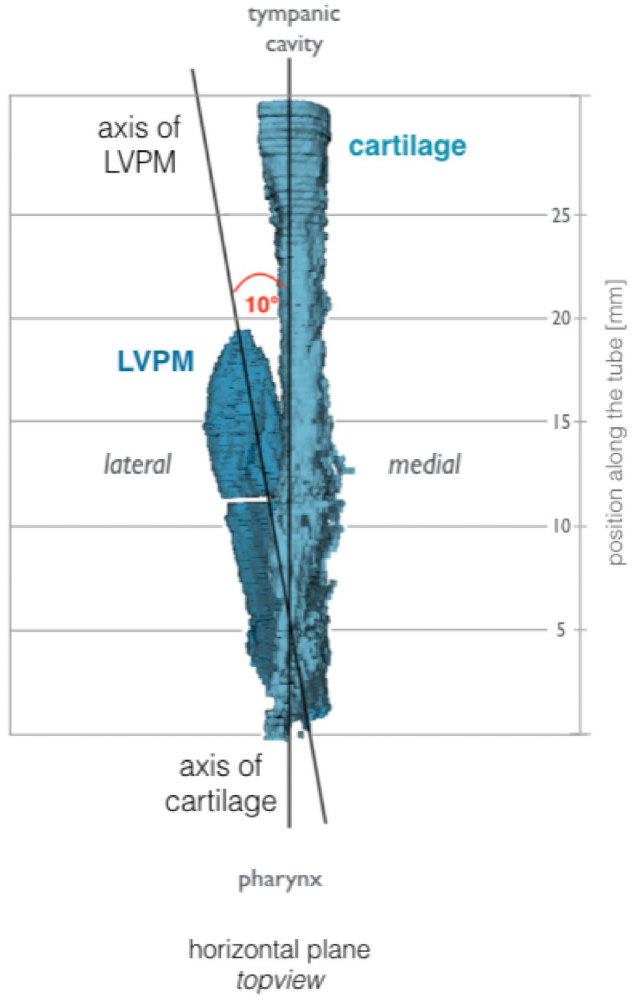
Fig 6. View from above on a right ET, pharyngeal orifice below. Relation of the tubal cartilage and the course of the LVPM. By the elevation of the soft palate by yawning and swallowing the muscle slides in the cartilage, initially from the pharyngeal opening to the upper third of the cartilage. Together with the upper-outward rotation with additional opening momentum by the force of the TVPM, the opening of the ET is initiated.